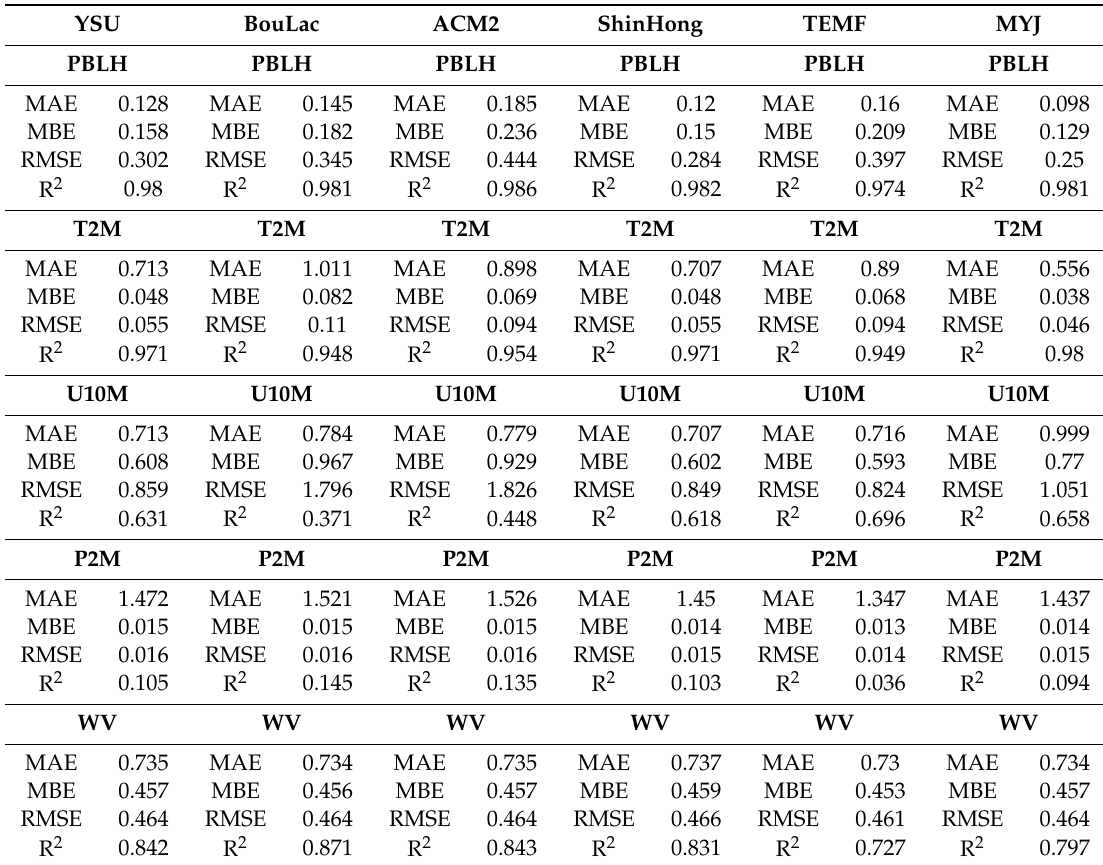
Table 1. Statistics of simulated PBLH, T2M, U10M, P2M and WV data compared to instrument-retrieved PBLH, T2M, U10M, P2M and WV data, 17 / 05 / 2017; performance indicators are MAE, MBE, RMSE, and R 2